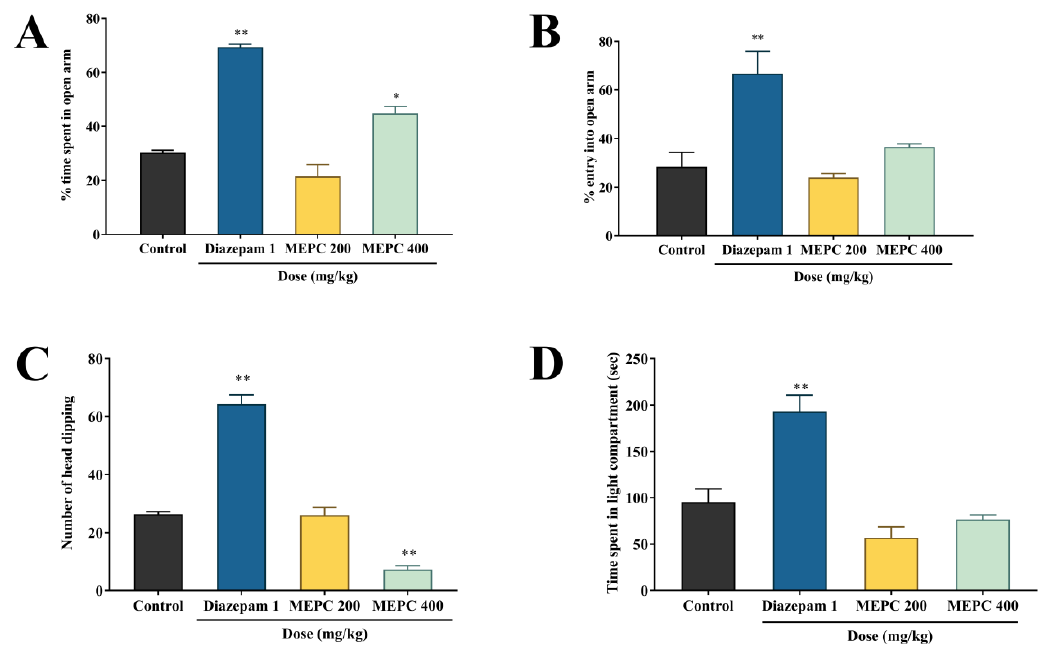
Figure 1. Anxiolytic activity of methanol extract of P. calocarpa (MEPC) and diazepam on elevated plus maze test, hole–board test and light and dark box test in mice. ( A ) % time spent in open arm, ( B ) % of entry into open arm, ( C ) number of head dipping and ( D ) time spent in light compartment. Values represented as mean ± SEM ( n = 5).* p < 0.01 and ** p < 0.001 considered as significantly different from the control (Dunnett’s test).